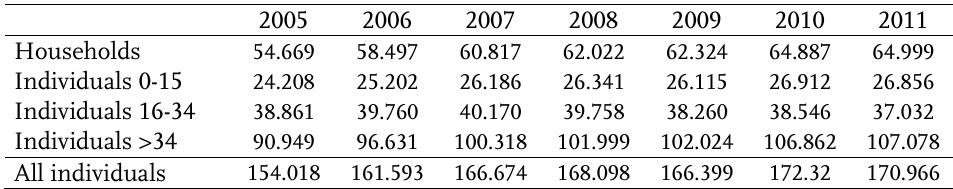
Sample size (number of observations) by groups in the second quarter of the year. 2005-2011